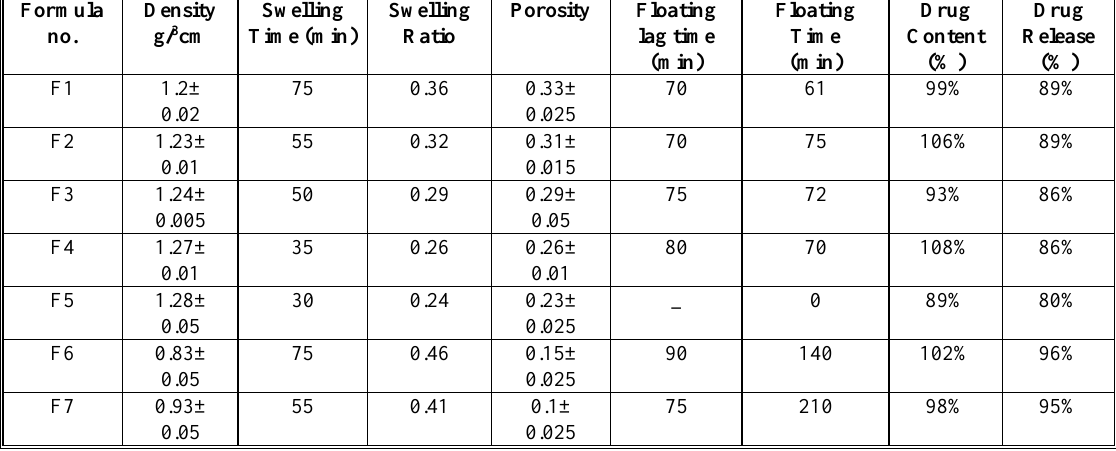
Table 4. Effect of Cross-linker Concentration and Type on Physical Properties of Carvidelol SPH Formula no.